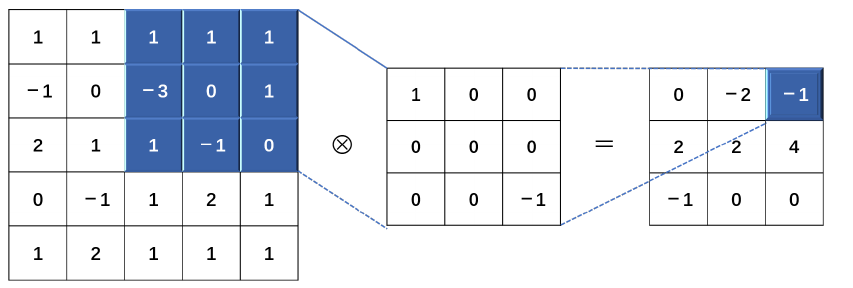
Figure 4. Convolution operation.